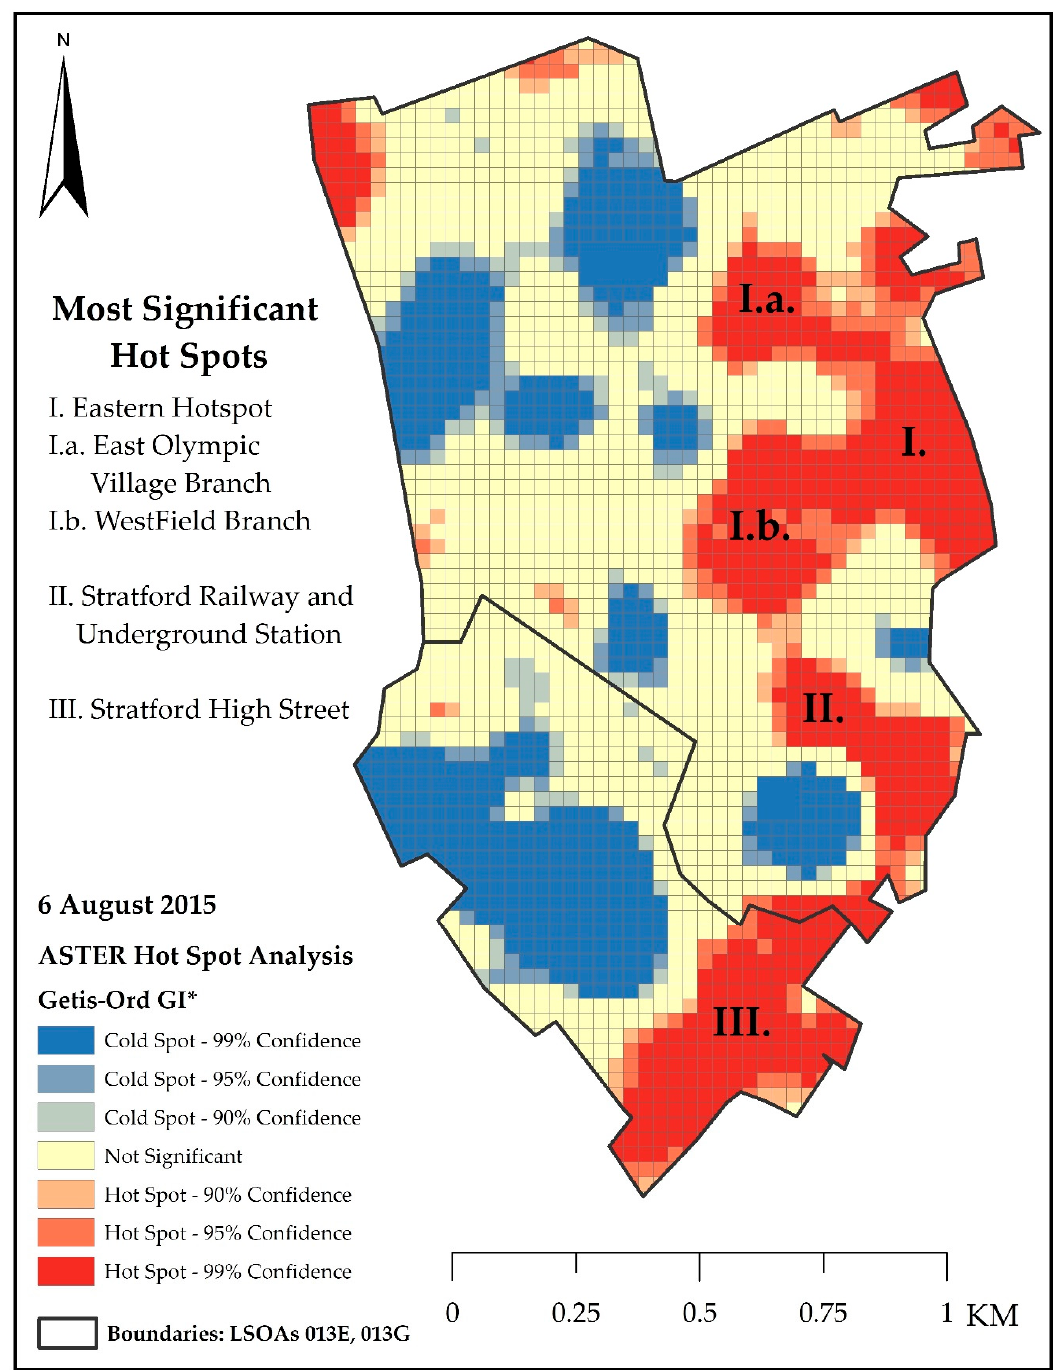
Figure 13. Identification of the most significant hot spots from cluster analysis performed on calculated LST from ASTER imagery (6 August 2015). Contains: National Statistics data © Crown Copyright and database right (2015) and (2012). Contains Ordnance Survey data © Crown Copyright and database right (2015) (2012) and also OS VectorMap ® Local [SHAPE geospatial data], Scale 1:10,000, Tiles: tq38ne, tq38se, Updated: 1 April 2016, Ordnance Survey (GB), Using: EDINA Digimap Ordnance Survey Service, <http://digimap.edina.ac.uk>, Downloaded: 8 December 2016 17:58:35.615.